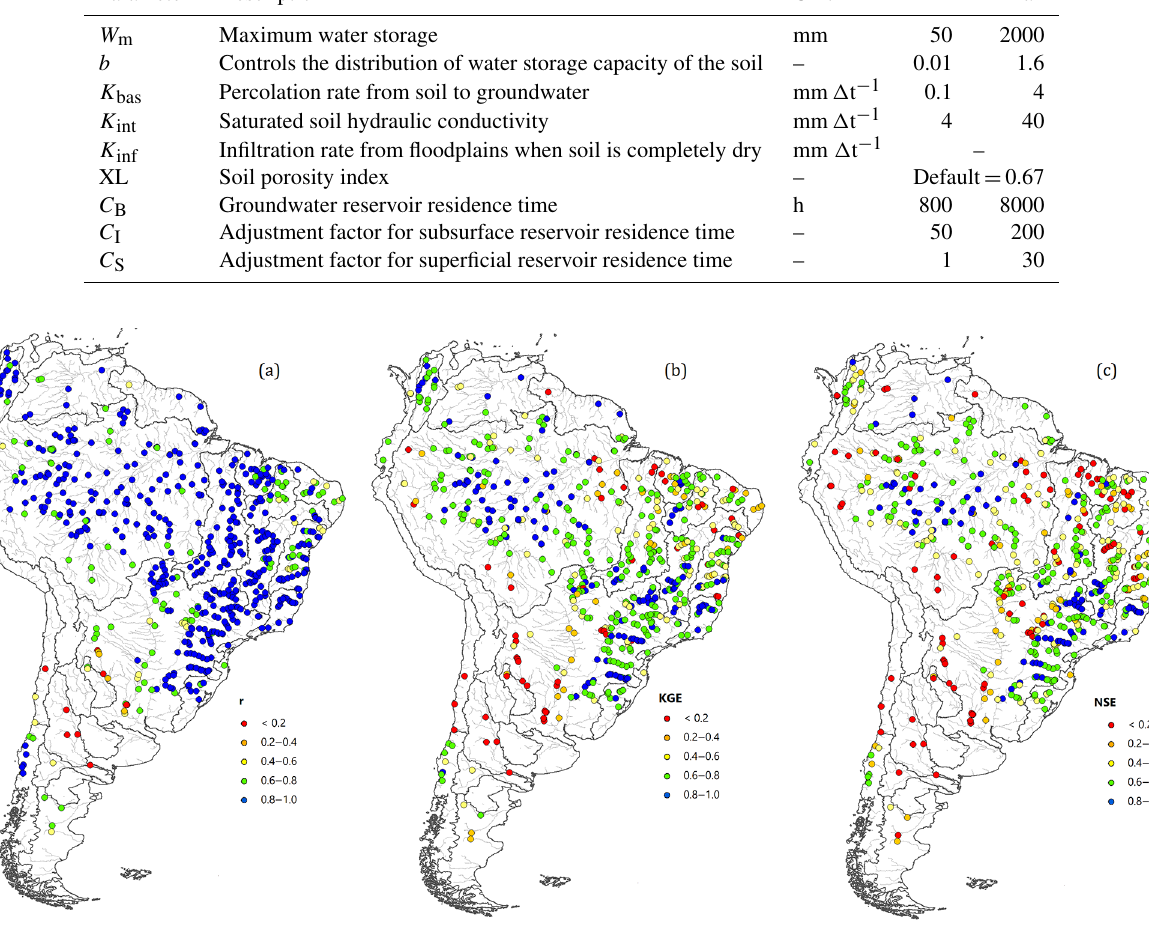
Figure 2. Discharge performance over South America in terms of (a) correlation ( r ), (b) Kling–Gupta efficiency (KGE) and (c) Nash– Sutcliffe